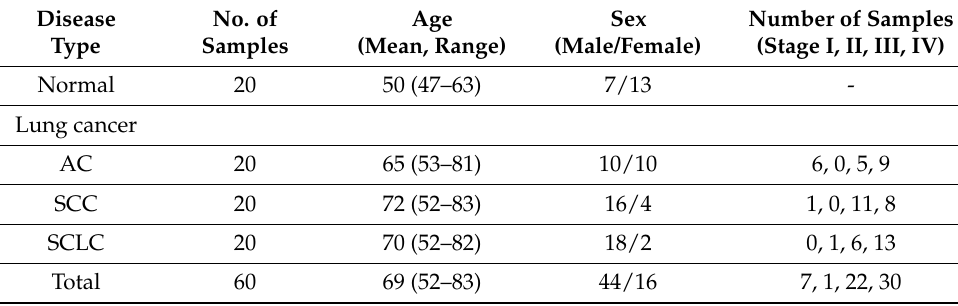
Table 1. Serum samples used for proteomic screening of